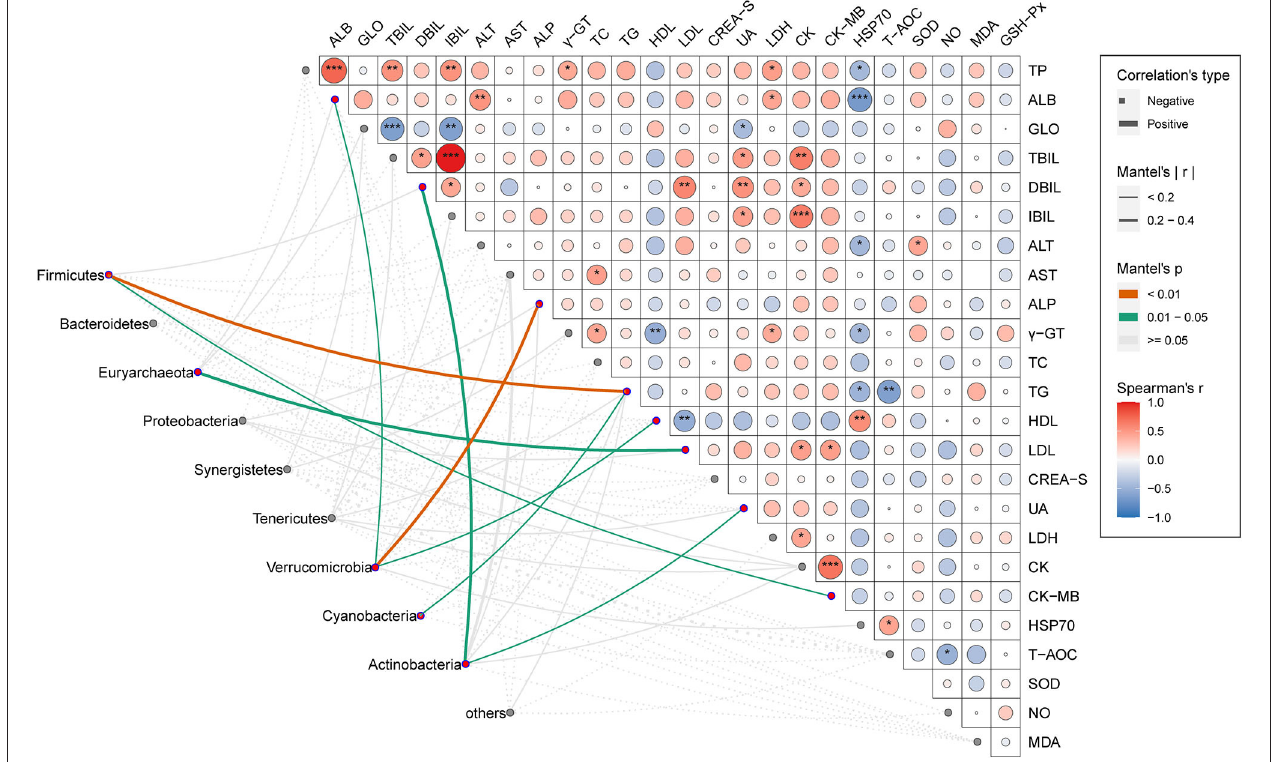
FIGURE 5 | Association between cecal microbial phyla and serum physiologic parameters. Pair-wise comparisons of a serum physiologic parameter in CHE hens were shown with a color gradient denoting Spearman’s correlation coefficients. The asterisk shows statistical significance. * p < 0.05; ** p < 0.01; *** p < 0.001. Taxonomic groups (phyla) were linked to each serum physiologic parameter by using the Mantel test. The edge thickness denotes the Mantel’s r statistic for the corresponding correlations, and the edge color represents the statistical significance ( P -values) based on 999